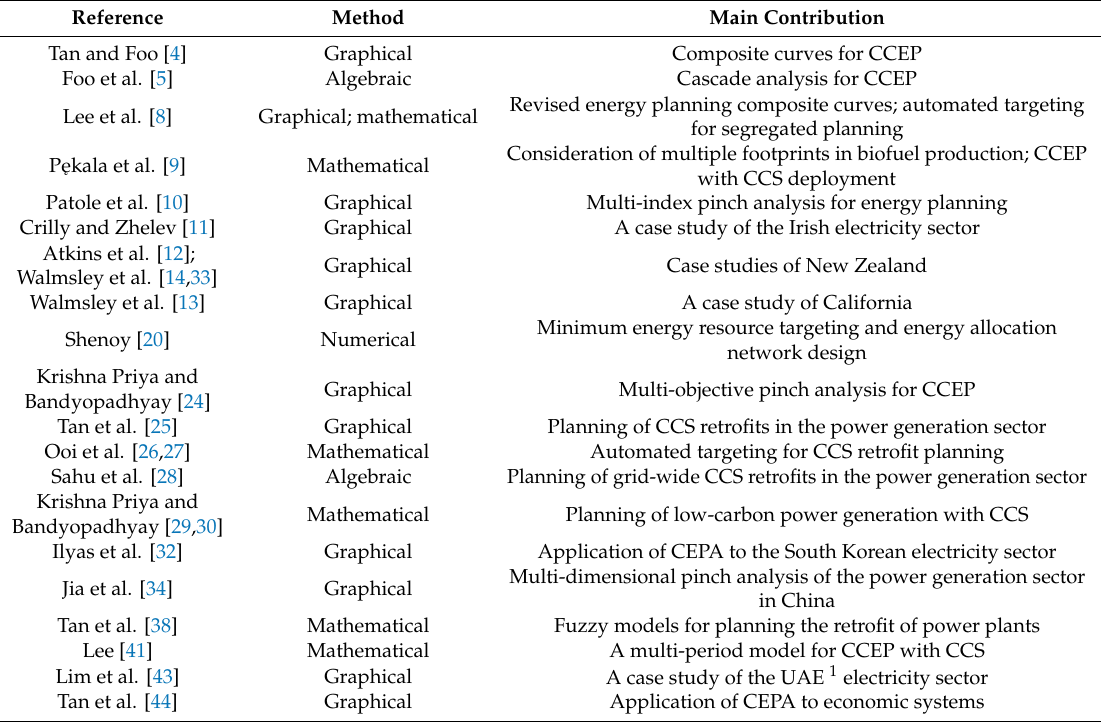
Table 1. Previous CCEP studies based on PI